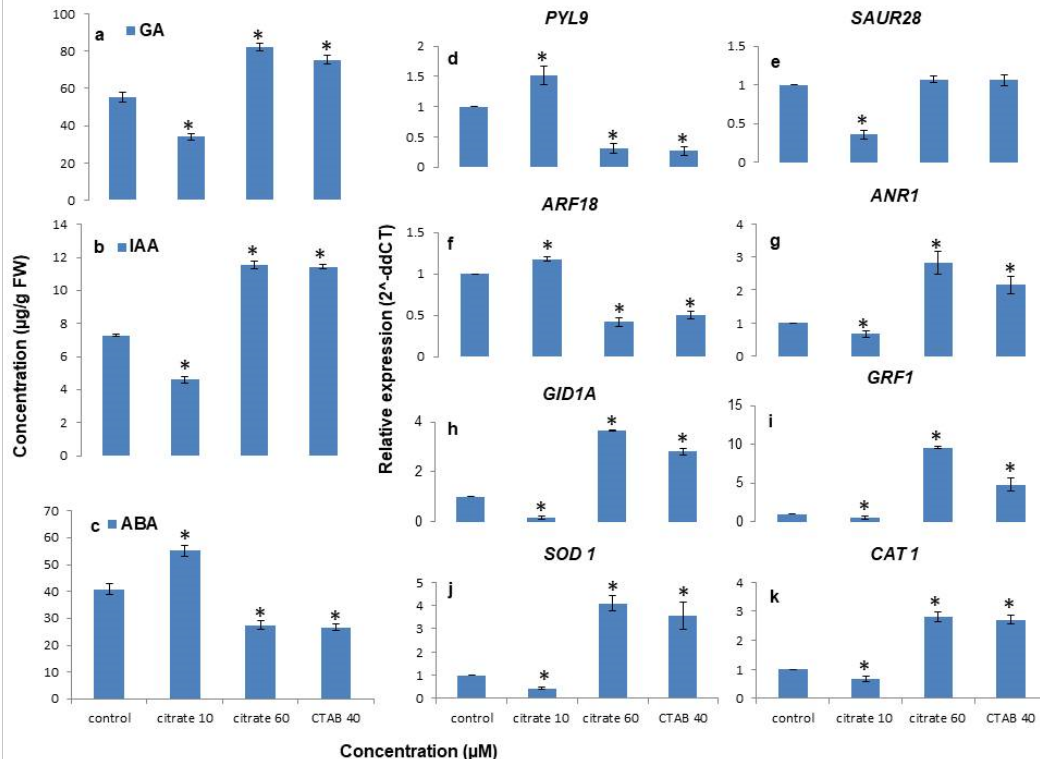
Figure 6. The effect of citrate-AuNPs and CTAB-AuNPs on the endogenous hormone level and relative transcript abundance of genes regulating antioxidant enzyme activities. ( a ) endogenous GA3 content; ( b ) endogenous IAA content; ( c ) endogenous ABA content; ( d – k ) relative transcript abundance of genes regulating endogenous hormone contents and antioxidant enzyme activities. Error bar represents the standard error of three biological replicates. * Indicates significant difference at p < 0.05 with respective control.